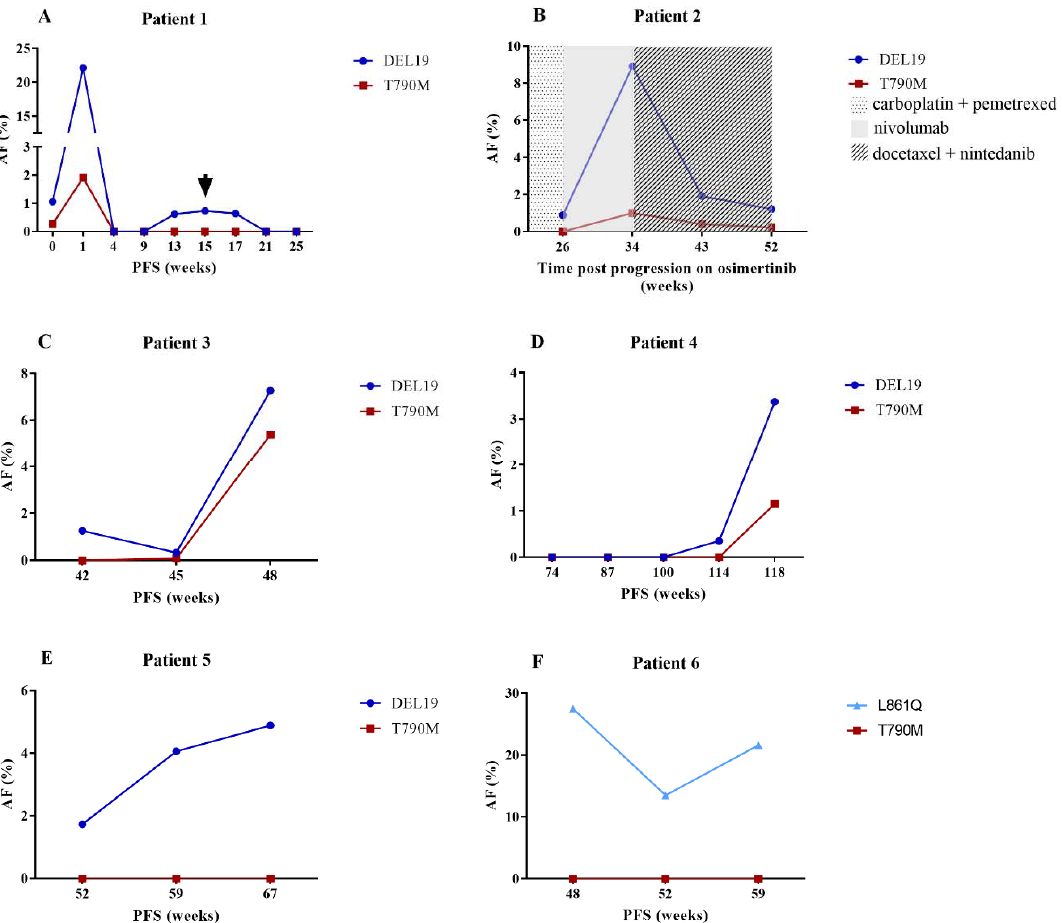
Figure 3. Kinetics of mutated ctDNA. ( A ) initial increase and decrease until undetectable levels of mutated ctDNA after osimertinib therapy. A spike of the activating mutation was detected from week 13 until week 17. At week 15, brain metastases with penetration of the blood brain barrier were detected via brain magnetic resonance imaging (MRI); ( B ) the T790M mutation follows the pattern of the activating mutation throughout several treatment schemes, however, at lower allele frequencies; ( C , D ) the activating mutation was detected at very low allele frequencies. A blood sample in a few weeks’ time resulted in the detection of increased allele frequency of this mutation together with the T790M resistance mutation. This corresponded with progressive disease to first ‐ and second ‐ generation EGFR TKI therapy respectively; ( E , F ) increasing and extremely high AFs of the activating mutations were detected, respectively. Due to progressive disease under first generation EGFR TKI therapy, tissue biopsies were performed at the last time point, which confirmed the absence of the T790M mutation; AF (%): percentage of allele frequency; PFS: progression ‐ free survival in weeks; : brain MRI.